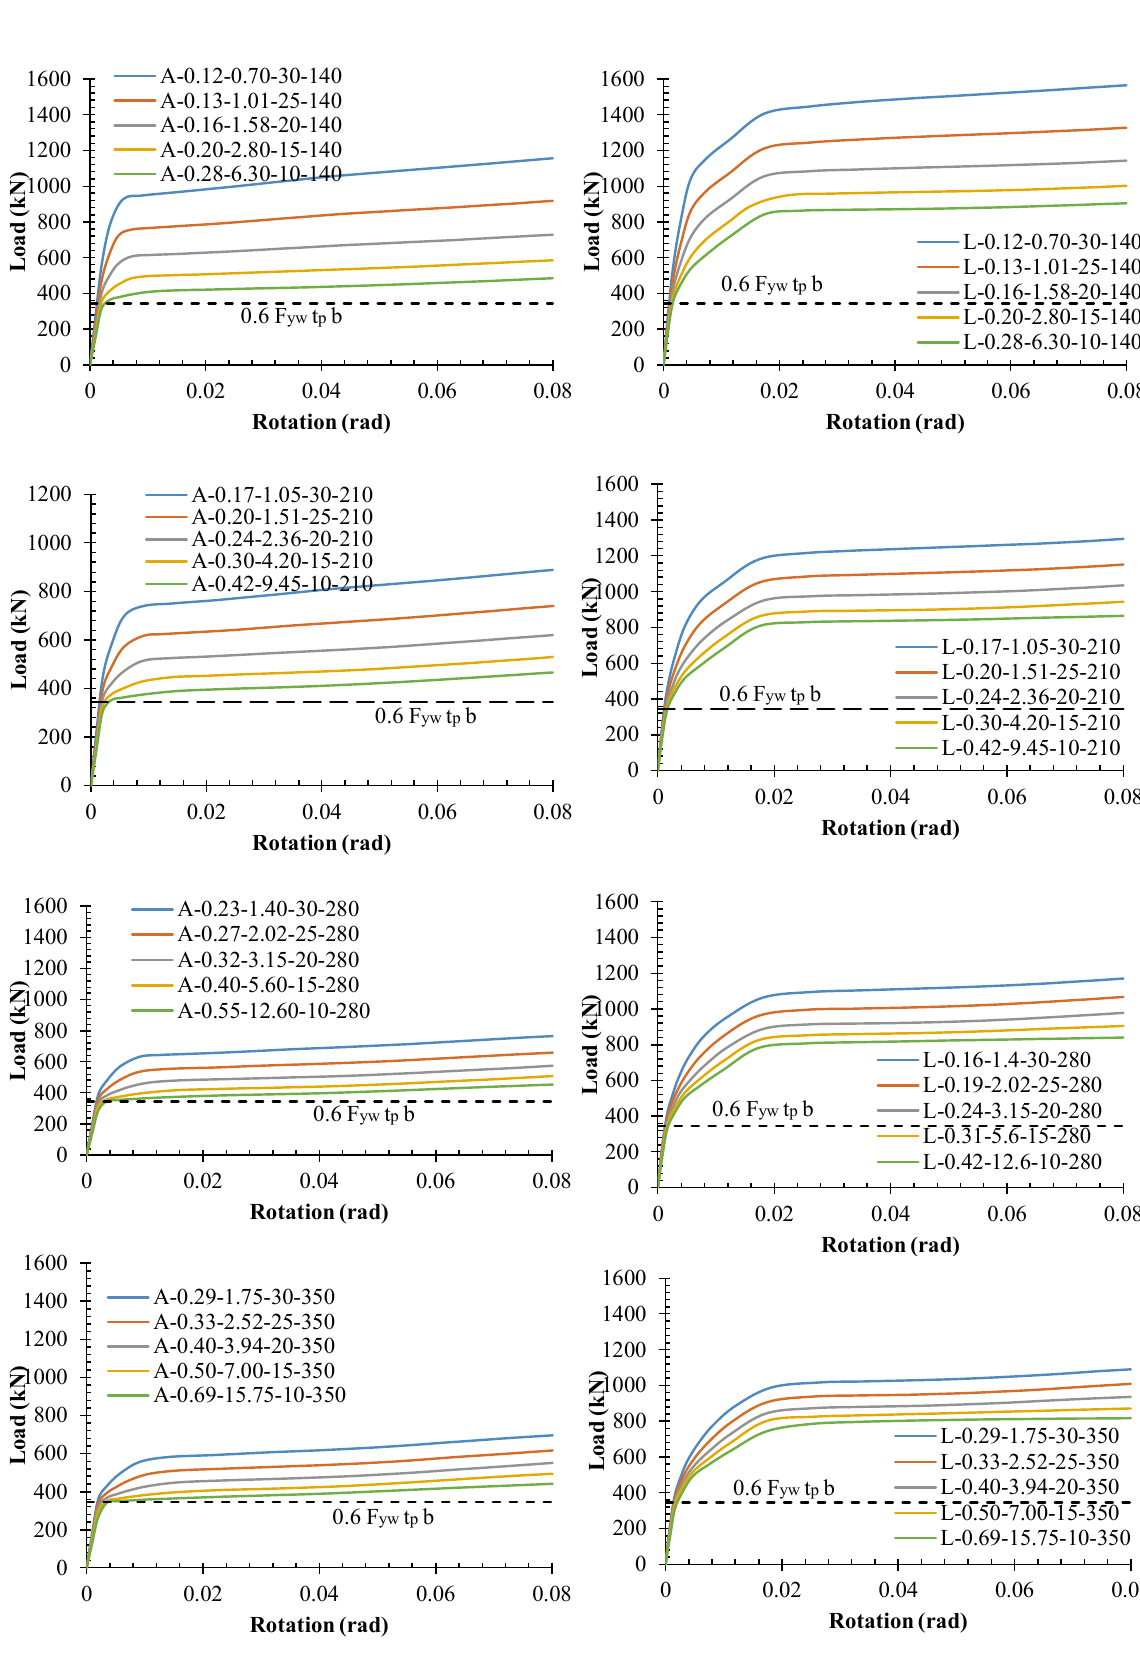
Figure 6. Load-rotation curves for FE models.